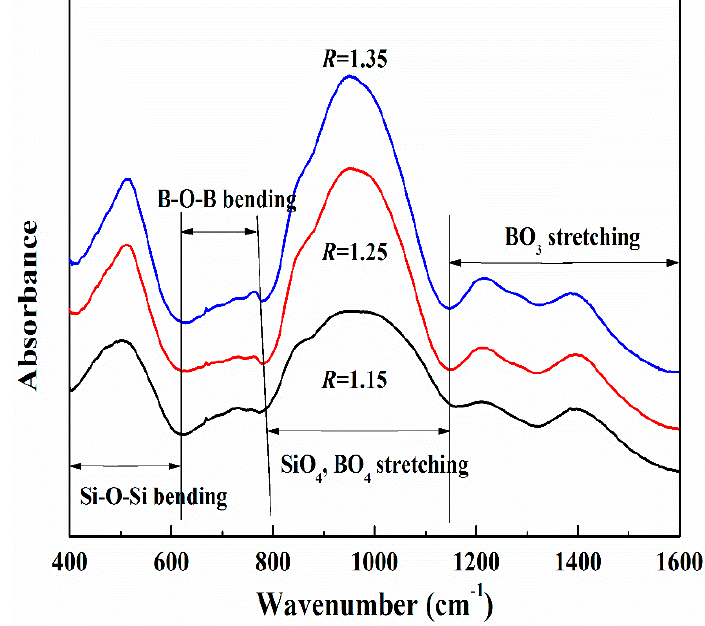
Figure 6. Infrared spectrum of fluorine-free mold fluxes.